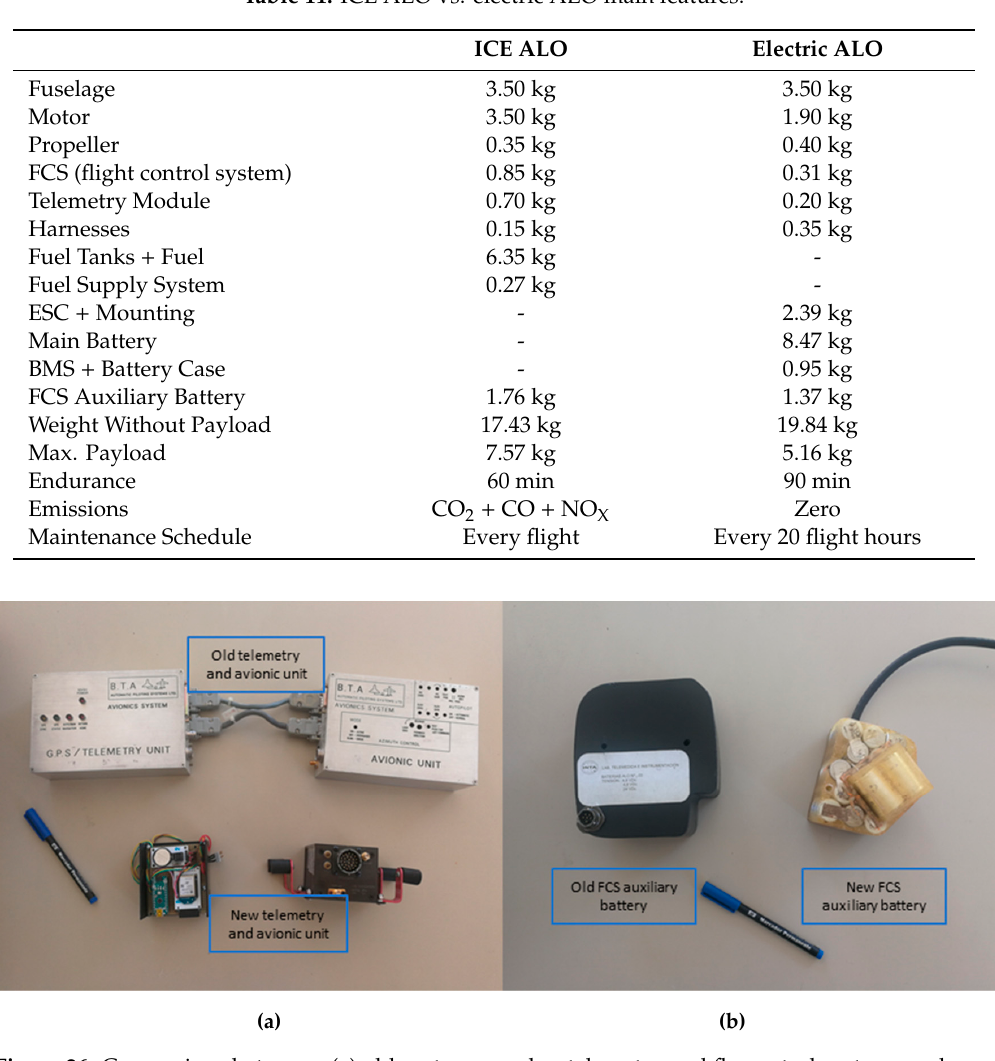
Figure 26. Comparison between: ( a ) old systems used as telemetry and fly control systems and new ones and ( b ) new and old batteries necessary to feed the FCS.